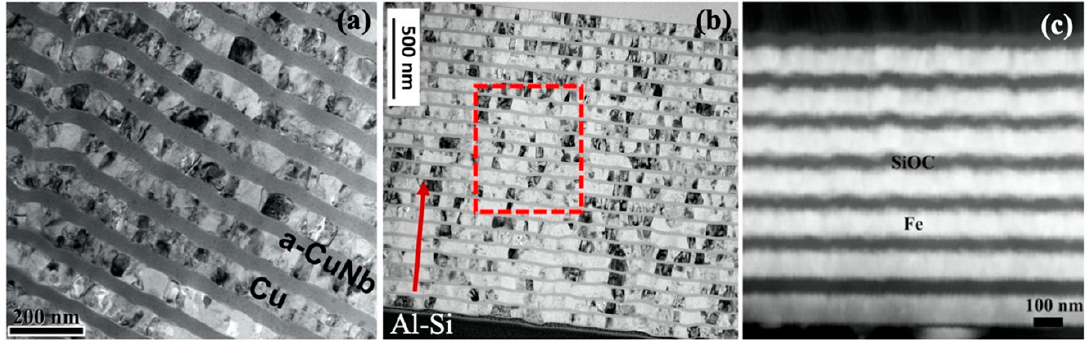
Figure 1. Transmission electron microscope (TEM) images of crystalline–amorphous multilayers synthesized by physical vapor deposition techniques: ( a ) crystalline Cu layers and amorphous CuNb (metallic glass) layers [74], ( b ) crystalline Al layers and amorphous Si layers [71], and ( c ) crys- talline Fe layers and amorphous SiOC layers